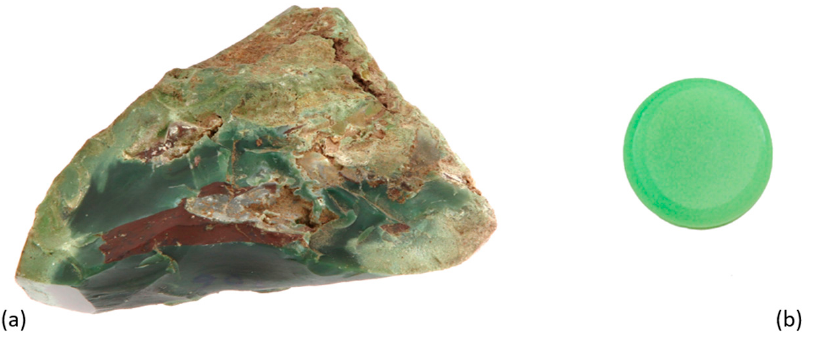
Figure 4. ( a ) Chromium-chalcedony mineralogical sample (Photo: M. Musa—GIG) and ( b ) chrysoprase-polished cabochon (Photo: M. Musa—GECI reference stone collection) .